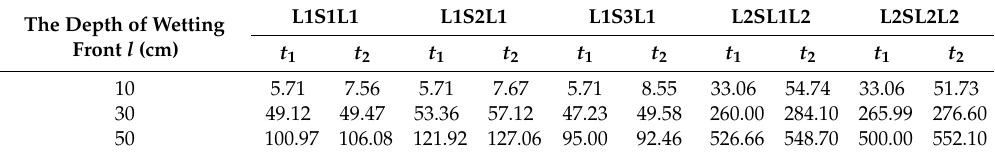
time t 2 after the cumulative infiltration reached the value of I at l for the MGA-2 calculation.